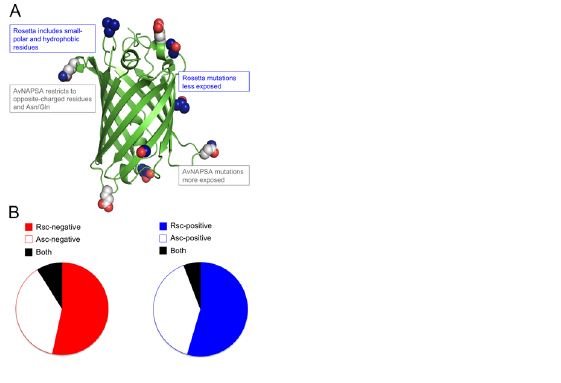
Figure 4. Rosetta and AvNAPSA supercharge protocols mutate different residues . A) AvNAPSA-mutated residue positions (white) are highly exposed and are often in loop regions, while Rosetta- mutated residue positions (blue) are less exposed and two mutations are in stable secondary structures. Native side chains of the mutated positions are shown in spheres to convey that Rosetta can mutate hydrophobic and small-polar residues. We emphasize that no mutations are shared between the two approaches in this low-charge design. B) Moderate supercharging was performed on 600 monomeric proteins, and the mutated residues were compared – each monomer was designed with the same net charge in both approaches. Rosetta requires more mutations to achieve the same net charge (solid v. empty). For negative-charge designs, 9% of mutated residue positions are shared (black, left). For positive-charge designs, 6% of mutated residue positions are shared (black, right). Shared mutations decrease an additional , 2-fold considering that the chosen residue type differs , 50% of the time for the shared residue positions – AvNAPSA never uses arginine, and AvNAPSA only uses aspartate if the native residue is asparagine.